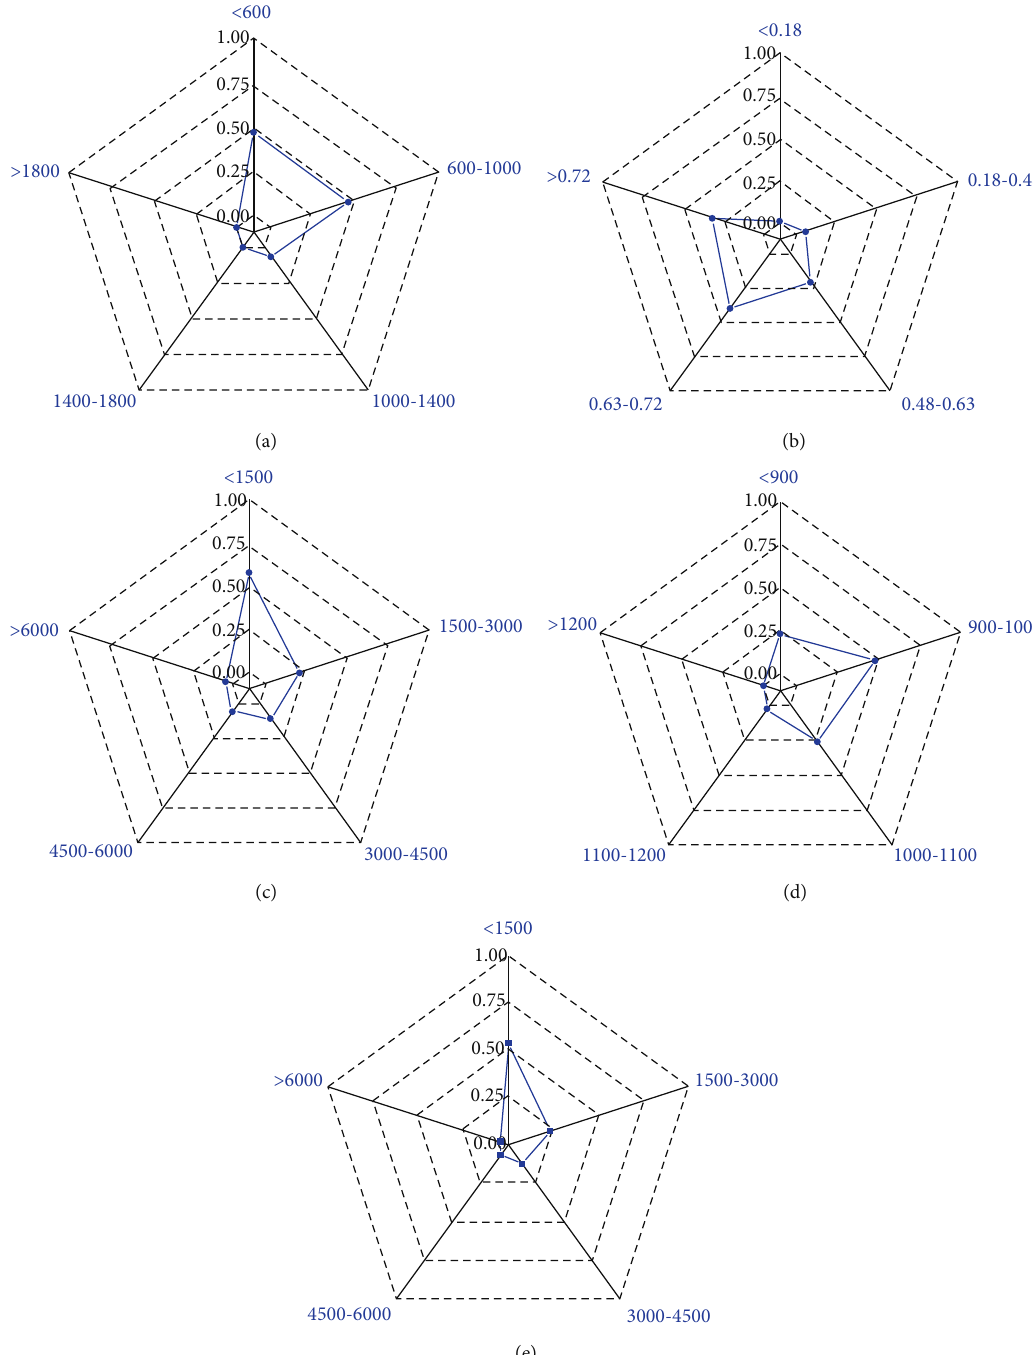
Figure 11: Distribution with high and very high landslide sensitivity based on GA-RF model on (a) elevation thematic map, (b) NDVI thematic map, (c) distance to roads thematic map, (d) rainfall thematic map, and (e) distance to rivers thematic